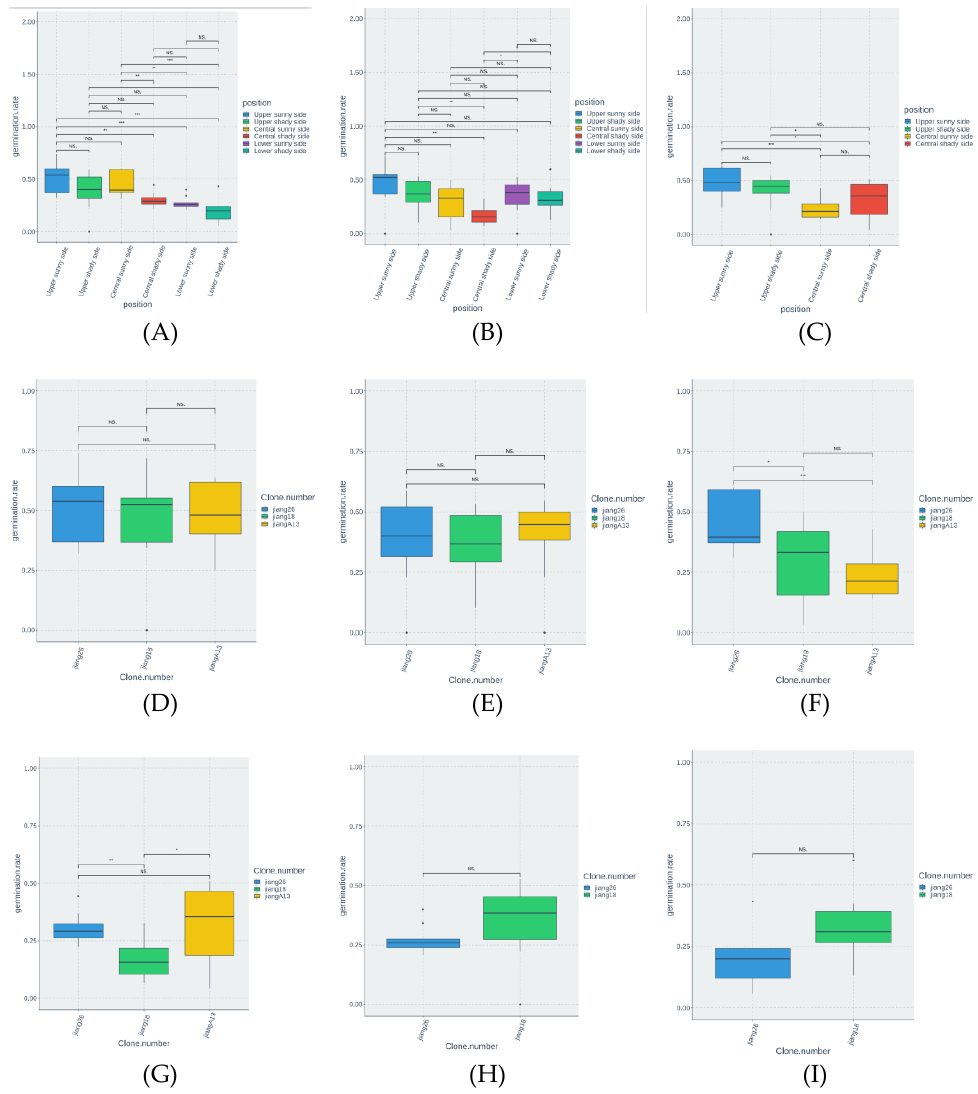
Figure 1. ( A ) Germination rate of Chinese fir clone jiang26 in different crown layers, ( B ) germination rate of clone jiang18 in different crown layers, ( C ) germination rate of clones jiangA13 in different crown layers, ( D ) germination rate of Chinese fir clones from the upper sunny side, ( E ) germination rate of clones from the upper shady side, ( F ) germination rate of clones from the central sunny side, ( G ) germination rate of clones from the central shady side, ( H ) germination rate of clones of different from the lower sunny side, (I) germination rate of clones from the lower shaded side. Significance